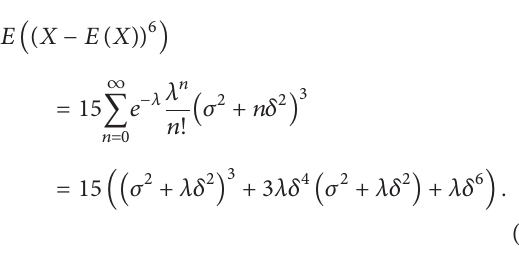
Figure 1: First passage time.